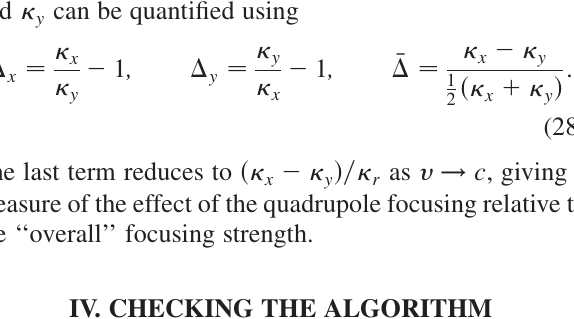
FIG. 6. The expansion coefficients of E region at t ¼ 0 . Shown here are E ð 1 Þ r (dark blue), E ð 1 ; 0 Þ x (green), E ð 0 ; 1 Þ y (red), and the average the two (light